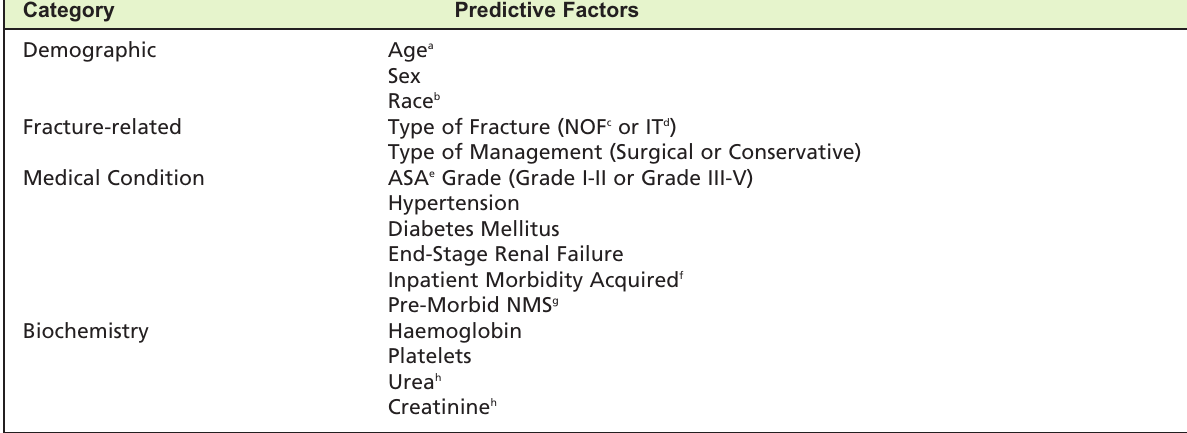
Summary of all potential predictive factors Table IV: